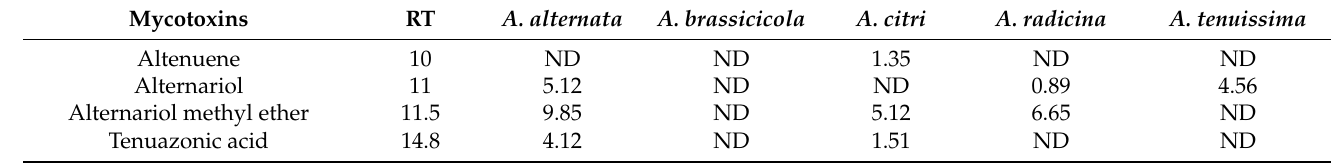
Table 2. HPLC analysis of Alternaria toxins (calculated by µg/mL of fungal extracts).